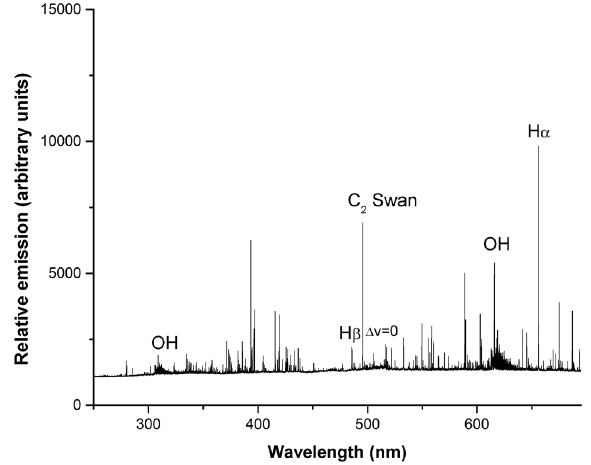
Figure 3 : Stark broadening of the H Run-9 recorded 70 mm beneath the torch.